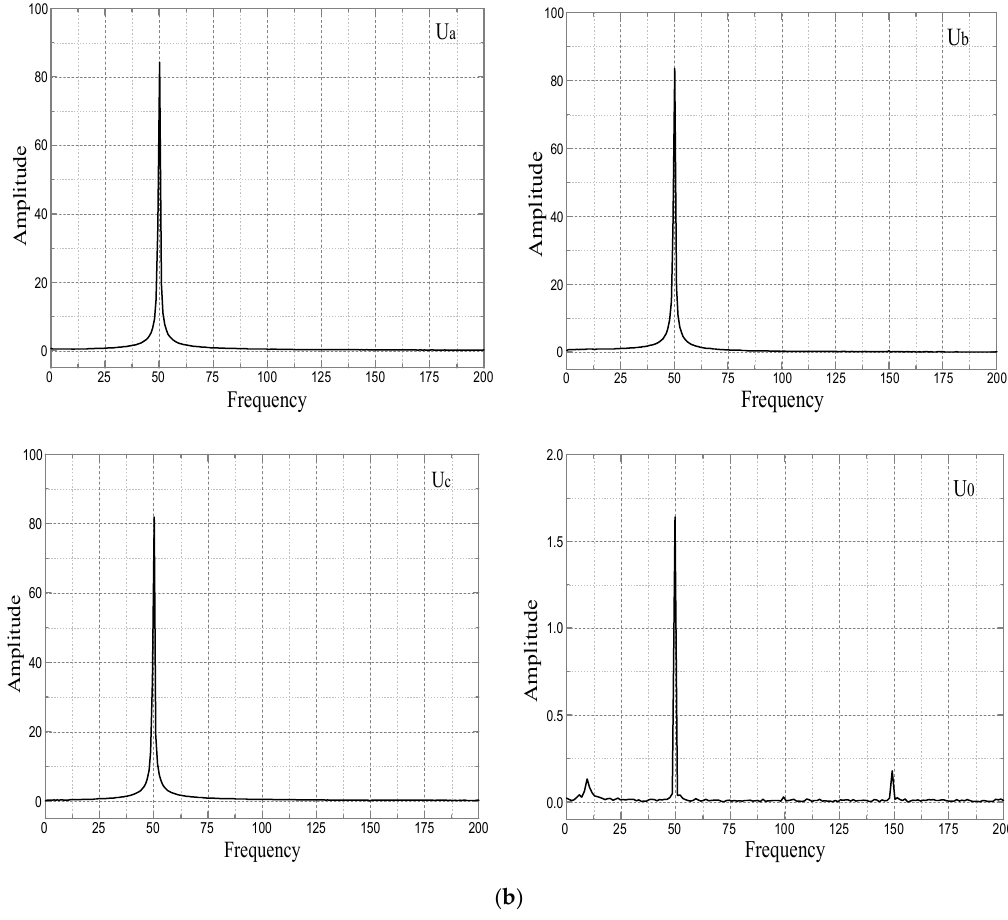
Figure 19. Amplitude of the frequency spectra of phase voltages. ( a ) Before KM is closed; ( b ) after KM is opened.